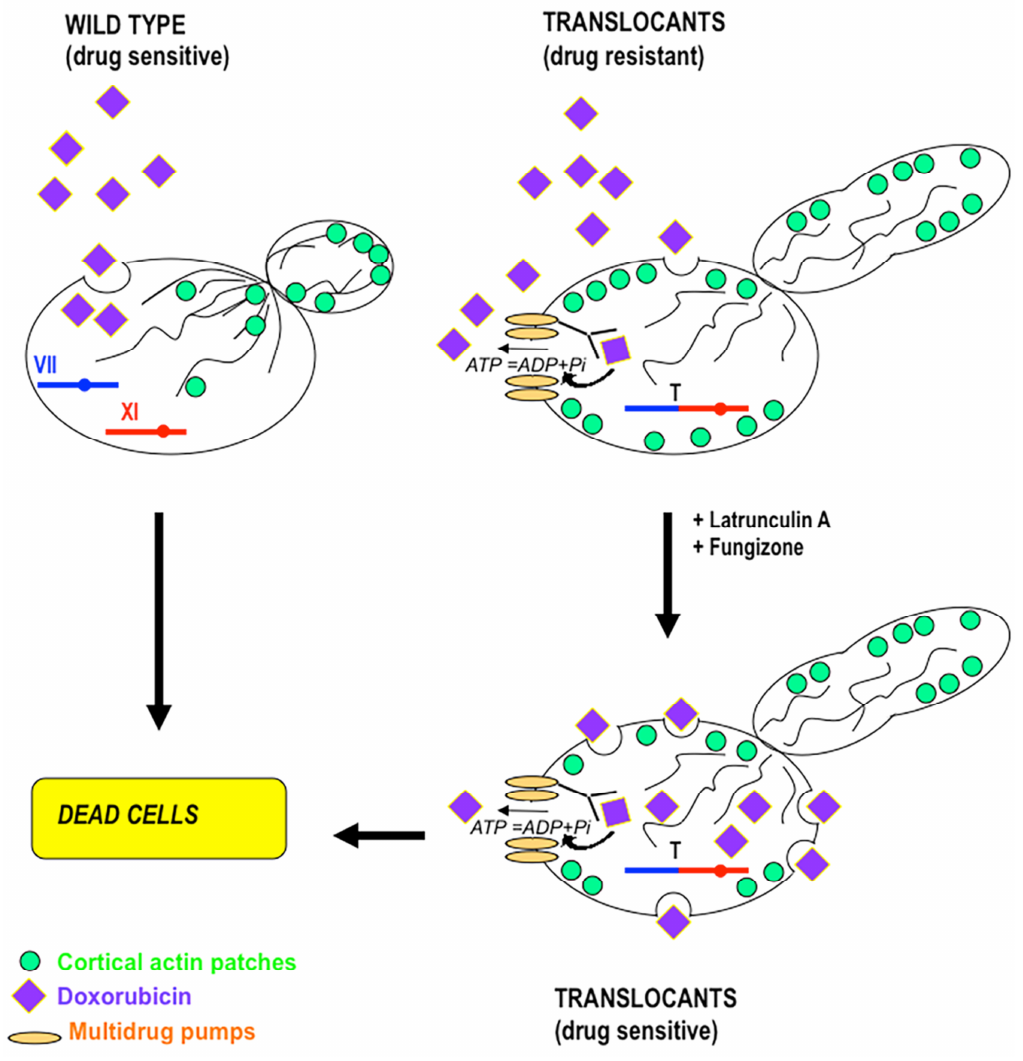
FIGURE 4: A schematic representation of the molecular mechanism for drug-resistance in diploid yeast translocant strains over-expressing PRK1 and PDR genes. The effect of doxorubicin on a wild type strain and on a translocant strain is compared. Doxorubicin can easy enter into a wild type yeast strain, killing it. On the contrary, due to the disaggregation of actin cortical patches and to over-expression of multidrug pumps, the translocants become resistant to doxorubicin. The addition of sub-lethal doses of fungizone and latrunculin A allows bypassing the drug resistance and makes yeast translocants even more sensitive to doxorubicin [62]. Here, a hypothetical translocation between chro- mosome VII and chromosome XI is represented. For illustration purposes, only one chromosome (the one involved in the translocation) of each pair is OPEN ACCESS | www.microbialcell.com